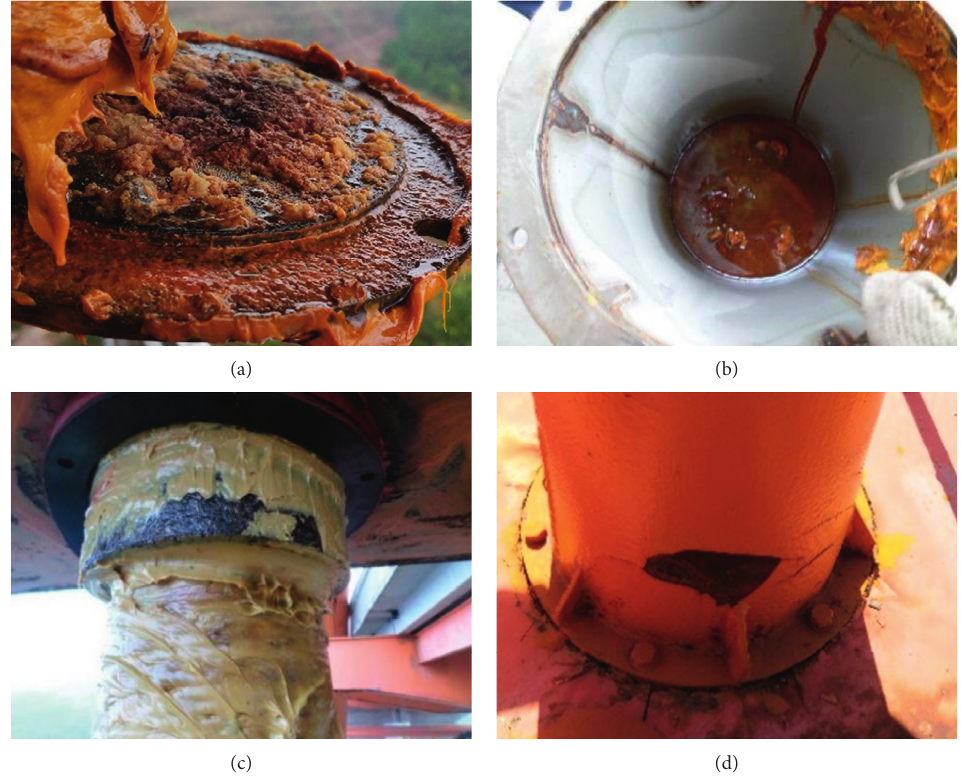
Figure 2: Anchorage damage: (a) water accumulation at the anchorage end; (b) water seepage of the anchor head; (c, d) corrosion of the anchor cup of the suspender.